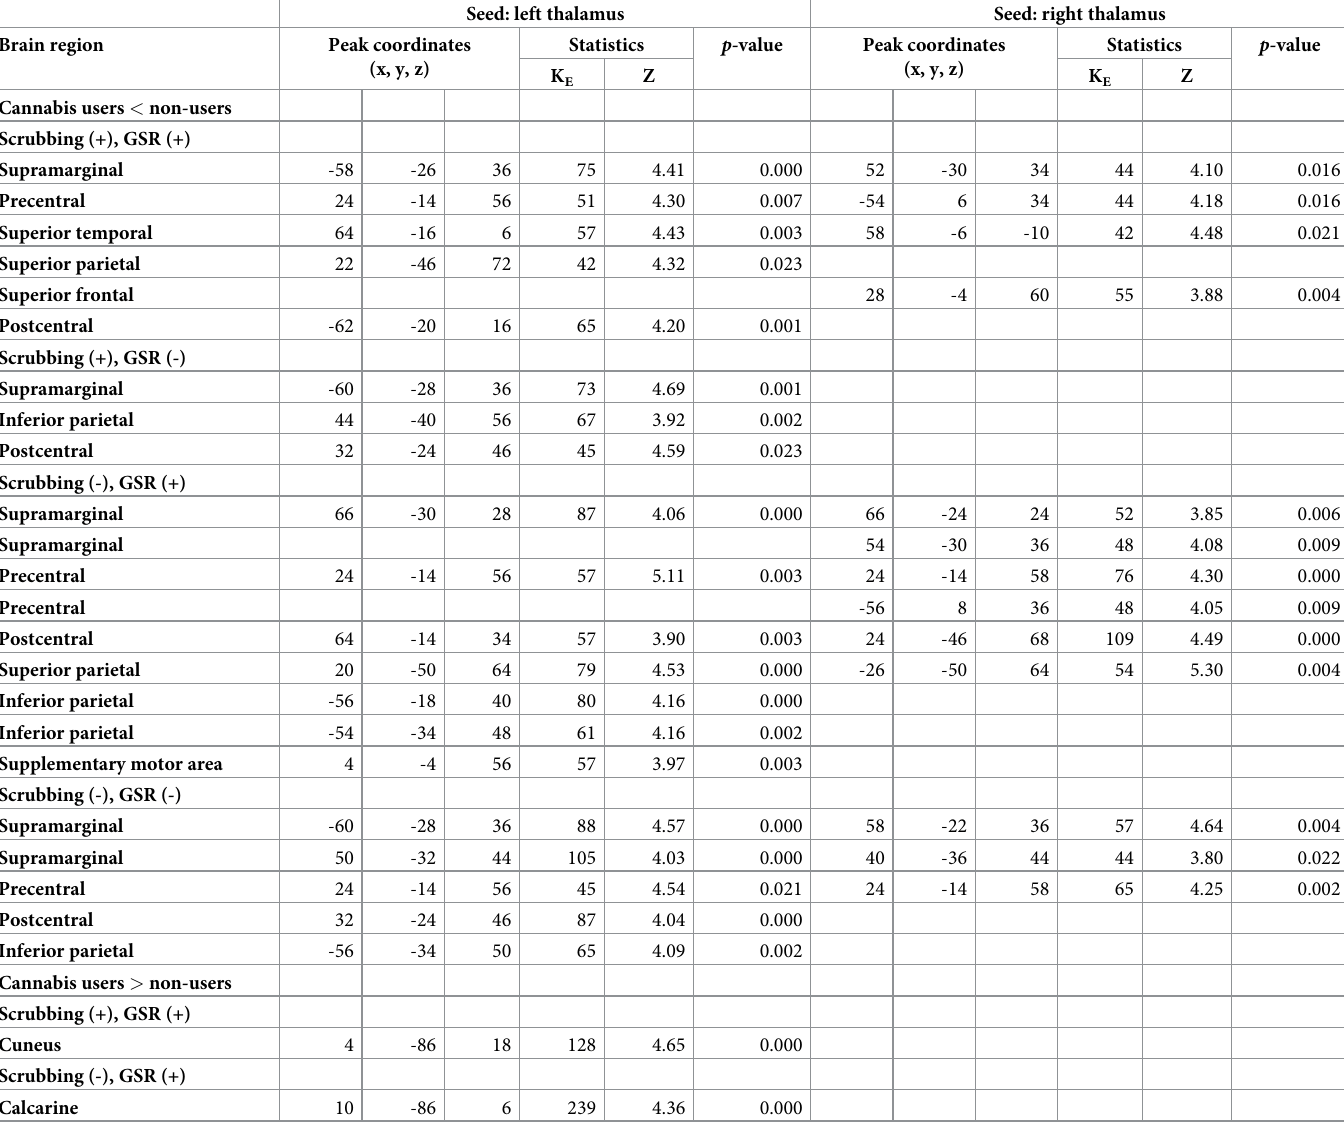
Table 2. Regional differences in thalamic functional connectivity between adult cannabis users and non-users, with childhood ADHD. Seed: left thalamus Seed: right thalamus Brain region Peak coordinates (x, y,